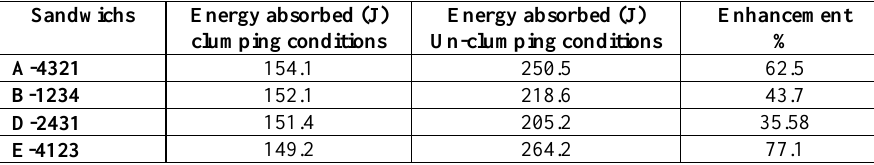
Energy absorbed (J) Un-clumping conditions